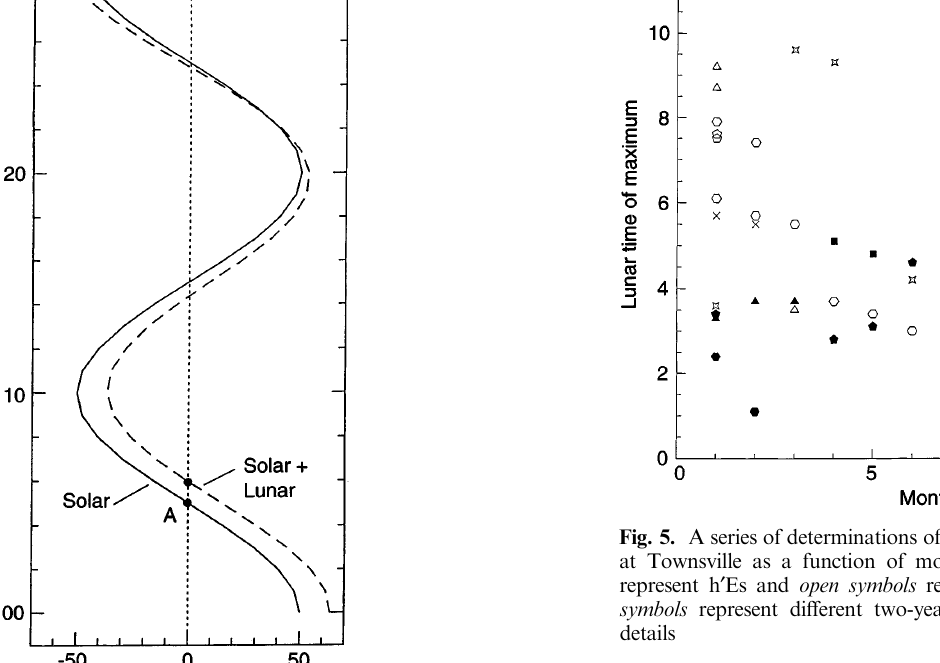
Fig. 8 for Vanimo (2.7 (cid:176) S, 141.3 (cid:176) E) using 14 y data from